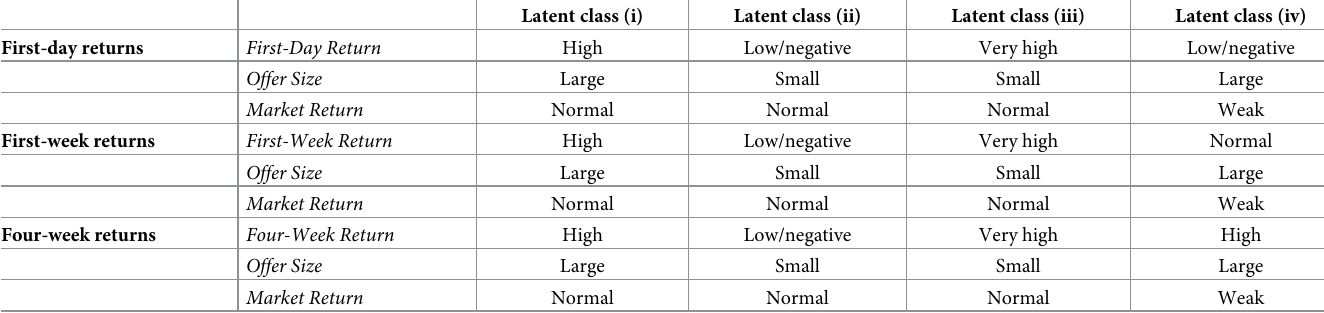
Table 8. Qualitative interpretations of the latent classes for first-day, first-week and four-week returns on the issuing firms’